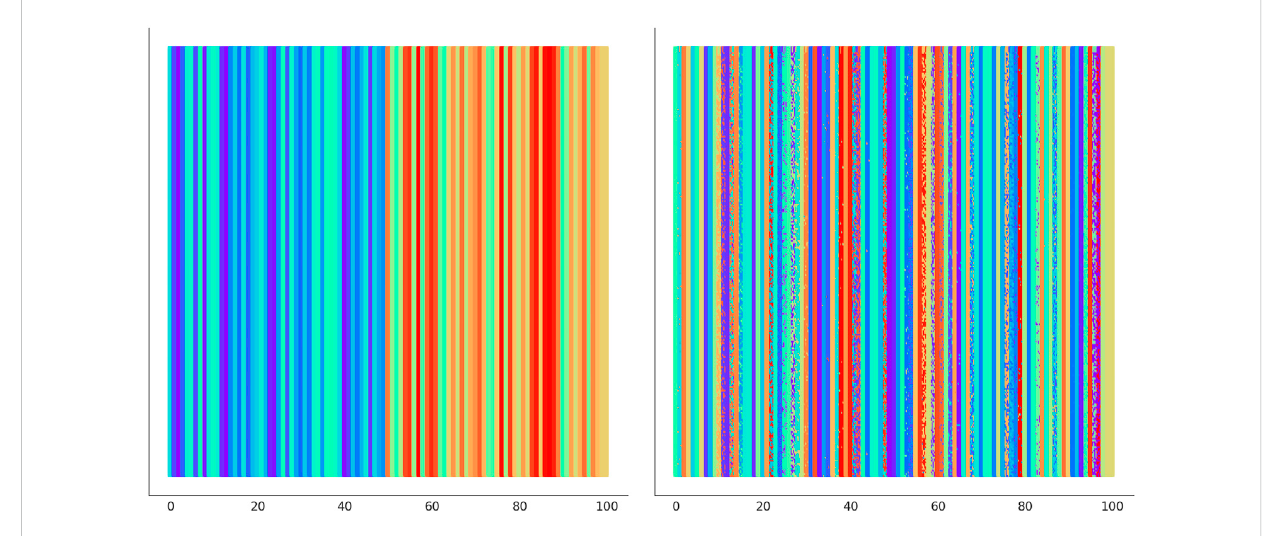
FIGURE 9 (Left)GoldstandardclusteringwhereeachbarcorrespondstoallthesignalspertainingthesameBCindataset D 2 .(Right)Clusteringoutcomewhere the signals are colored according to the result achieved with UNPLEX, non-uniform coloring in a bar indicates the presence of misclustered